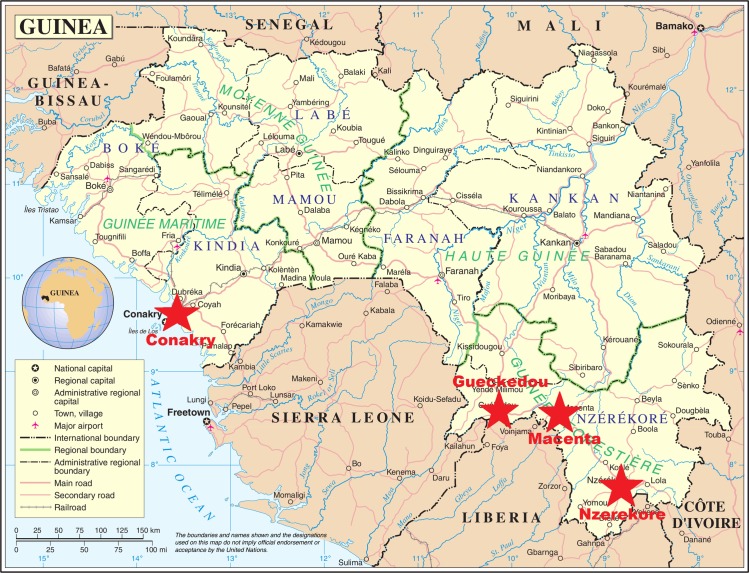
JIKI trial settings.The red stars indicate the four Ebola treatment centers that participated in the JIKI trial. Three were in the southern Guinean highlands (Gueckedou, Macenta, Nzerekore), and one was in coastal Guinea (Conakry). Source: Adapted from a Wikipedia map, derived from a United Nations map; public domain.